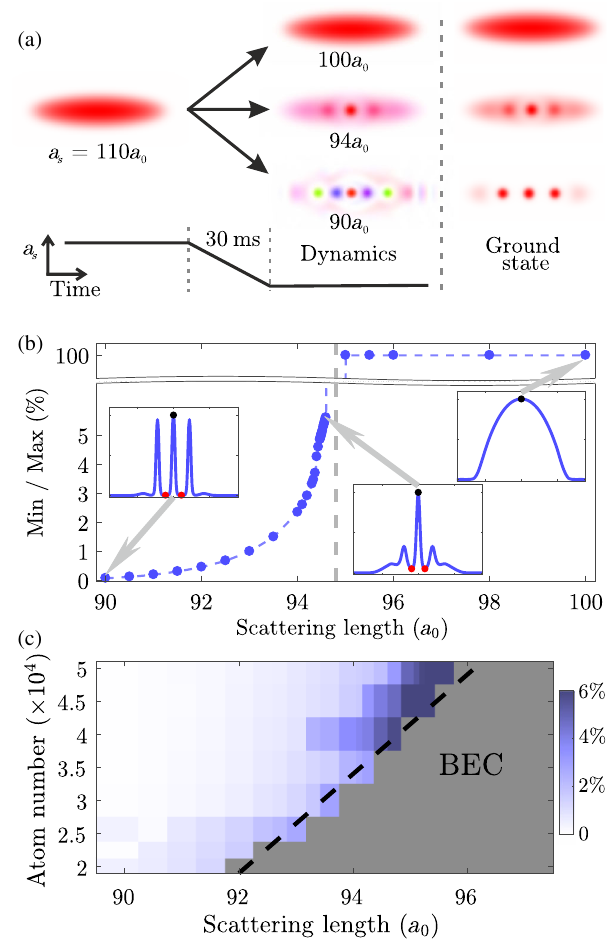
FIG. 1. Phase transition from BEC to immersed droplets to isolated droplets. (a) Schematic of the experimental sequence and corresponding ground states. We start from a BEC and then change the scattering length to its final value, where we observe three different regimes: at high scattering lengths a BEC, at low scattering lengths isolated droplets, and in between droplets immersed in a superfluid background. We compare the dynamical simulations to the corresponding ground states. The pictures show the phase in color scale weighted by the density distribu- tion. (b) To quantify the transition we calculate the ratio of the first minimum compared to the center peak height of the ground state containing 3 . 5 × 10 4 atoms. (c) Ground state phase diagram of this calculated ratio for different atom numbers and scattering lengths. Note that with higher atom number, the number of droplets, and, as a consequence, also their overlap increases. The dashed black line is a guide to the